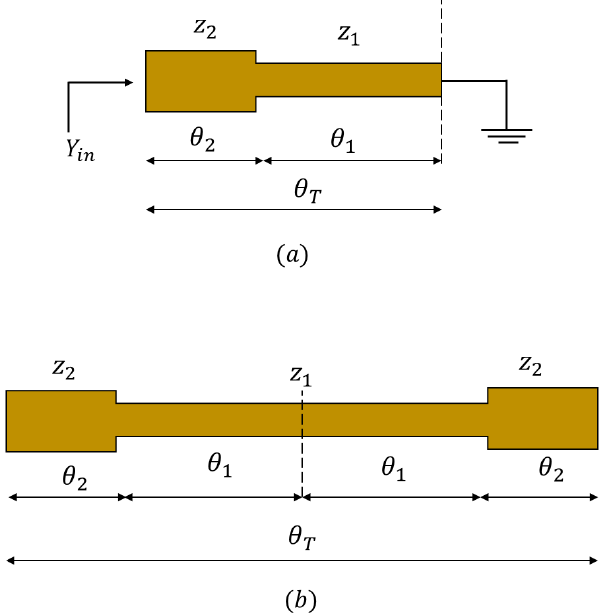
Figure 2. SIR varieties: ( a ) quarter-wavelength type; ( b ) half-wavelength type.